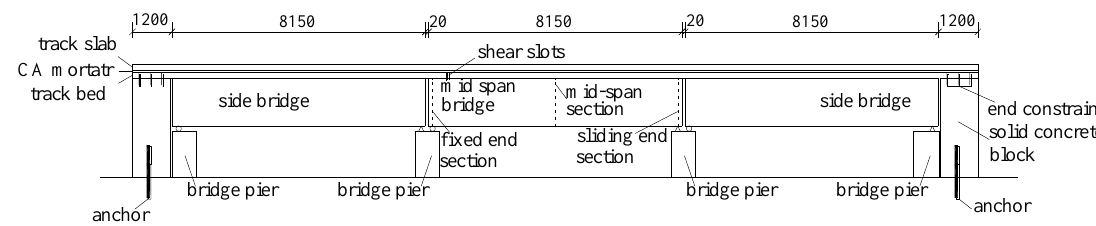
Figure 2. Elevation view of specimen structure (mm).